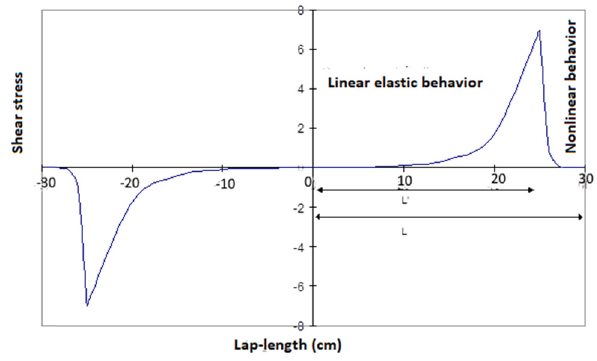
Figure 7: Variation of the shear stress along the overlap of the composite plate.